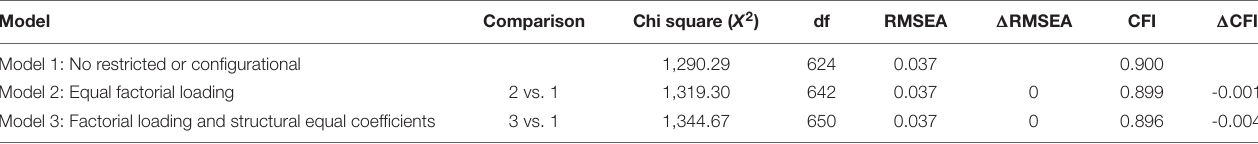
TABLE 9 | Statistical adjustment for invariance analysis.